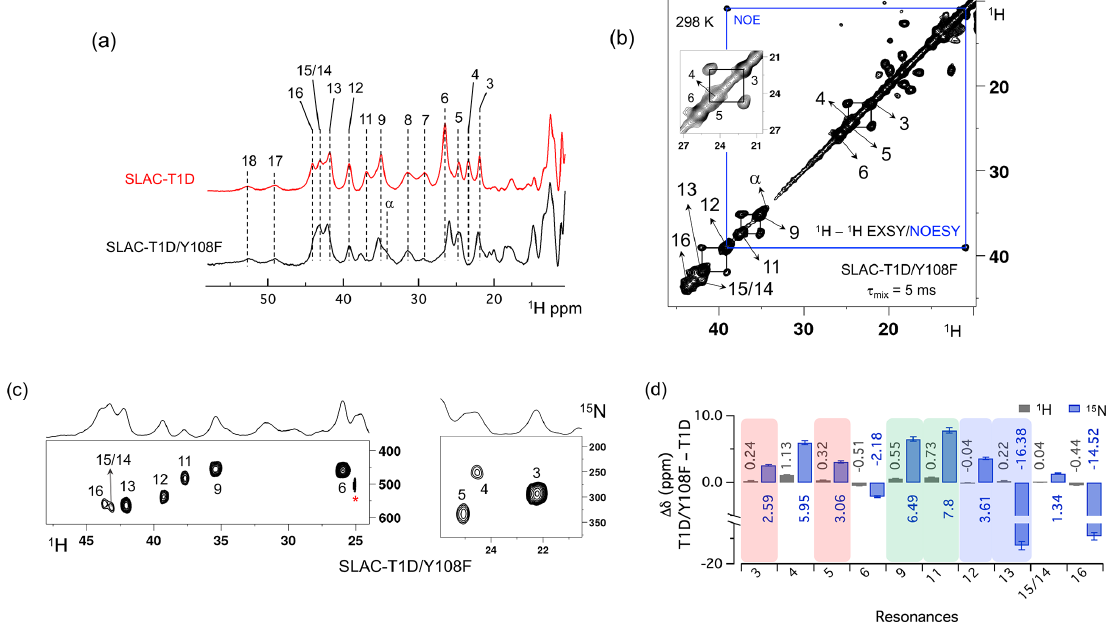
Figure 3. Spectra of SLAC-T1D/Y108F. (a) Comparison between the 1D 1 H WEFT spectrum of SLAC-T1D (red) and SLAC-T1D/Y108F (black). The numbering is shown for SLAC-T1D and is adopted from Dasgupta et al. (2020a); (b) 1 H– 1 H EXSY/NOESY of SLAC- T1D/Y108F at 298K with a mixing time of 5ms. NOE cross-peaks are connected with a blue rectangle. The remaining cross-peaks are exchange peaks. This distinction is based on the temperature-dependent profile of the integral volume of the cross-peaks as explained in Dasgupta et al. (2020a). The inset shows that the exchange cross-peaks are between 3 and 5. Resonance 4 partly overlaps with 5; (c) 1 H– 15 N HMQC spectra of 15 N uniformly labelled SLAC-T1D/Y108F. (d) The chemical shift changes ( (cid:49)δ ) between SLAC-T1D/Y108F and SLAC- T1D for the 1 H (black) and 15 N (blue). The error bars represent the standard deviation in the determination of the chemical shift. The three pairs of resonances displaying chemical exchange are highlighted by equal background colours. Positive (negative) values represent shift to the downfield (upfield) ppm for SLAC-T1D/Y108F.